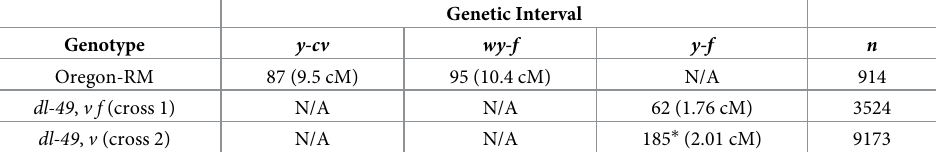
Table 1. Crossover frequencies in the specified genetic intervals for the full-sibling wildtype Oregon-RM and the dl-49 inversion. Number of recovered offspring are shown, and the corresponding cM is shown in parentheses